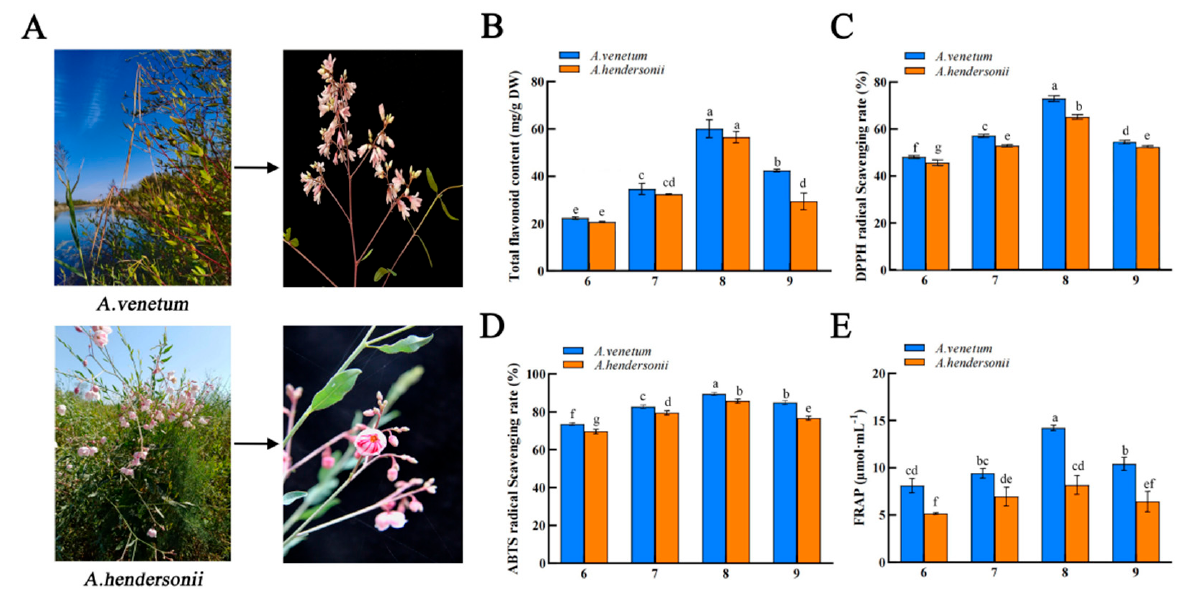
Figure 1. Morphology of A. venetum and A. hendersonii . ( A ) Total flavonoid content of A. venetum and A. hendersonii at different harvesting stages. ( B ) DPPH ( C ) and ABTS. ( D ) Radical scavenging activities, and FRAP. ( E ) The 6, 7, 8, and 9 represent the sampling periods June, July, August, and September, respectively. Histogram bars with different letters (a–f) are statistically different ( p < 0.05). In this study, the total flavonoid contents of the leaf extracts of A. venetum and A. hen- dersonii grown in the Ili River Valley Region at different harvesting stages were determined by the aluminum chloride colorimetric method. In addition, the antioxidant activities of the extracts at different harvesting stages were analyzed by DPPH, ABTS, and FRAP